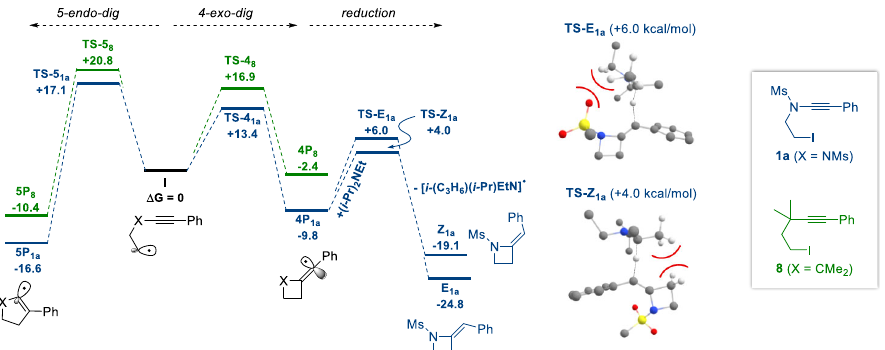
Fig. 7 Computational study. Computed free energy pro fi les of 4-exo-dig, 5-endo-dig and reduction ( 1a only) of 1a (blue) and 8 (green) from the respective radical species I at the M052X-D3,MeCN/def2-QZVPP/M052X-D3/def2-TZVP level of theory. Also shown are the structures of TS-E 1a and TS-Z 1a where differences in clashing of the vinyl radical and the amine reductant are highlighted to rationalize the kinetic predominance of Z isomer formation (hydrogens not involved in reduction or primarily in the clashing between the vinyl radical and amine are omitted